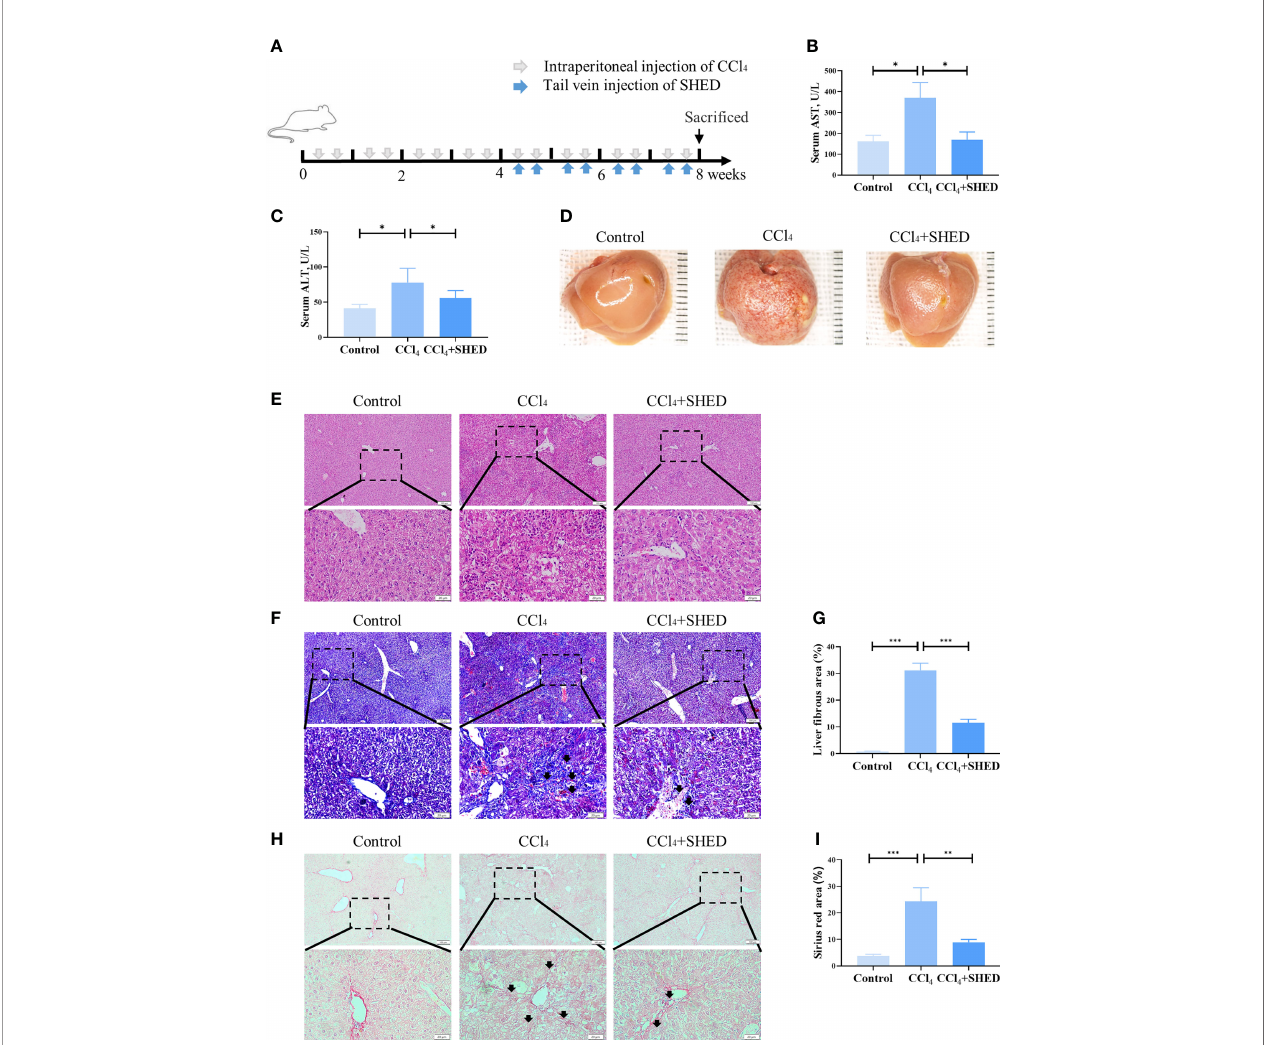
FIGURE 1 | SHED alleviated CCl 4 -induced liver cirrhosis. (A) The schema of CCl 4 injection to induce liver cirrhosis and SHED infusion in mice. (B, C) The levels of serum ALT and AST of control, CCl 4 , and SHED infusion groups. (D) The gross appearance of the liver tissues from control, CCl 4 , and SHED infusion groups. (E) H&E staining of liver tissues from control, CCl 4 , and CCl 4 mice with SHED infusion groups. (F, G) The collagen deposition in livers from control, CCl 4 , and SHED infusion groups, as assessed by Masson trichrome staining. Arrow heads, fi brous deposition. (H, I) Sirius red staining of fi brous septum in livers from control, CCl 4 , and SHED infusion groups. Arrowheads, fi brous septum. Scale bar: 100 and 20 m m. *p < 0.05, **p < 0.01, and ***p < 0.001. Graph bars show the mean ± SD. All of the assays were performed in triplicate. ALT, alanine aminotransferase; AST, aspartate aminotransferase; CCl 4 , carbon tetrachloride; SHED, stem cells from human exfoliated deciduous